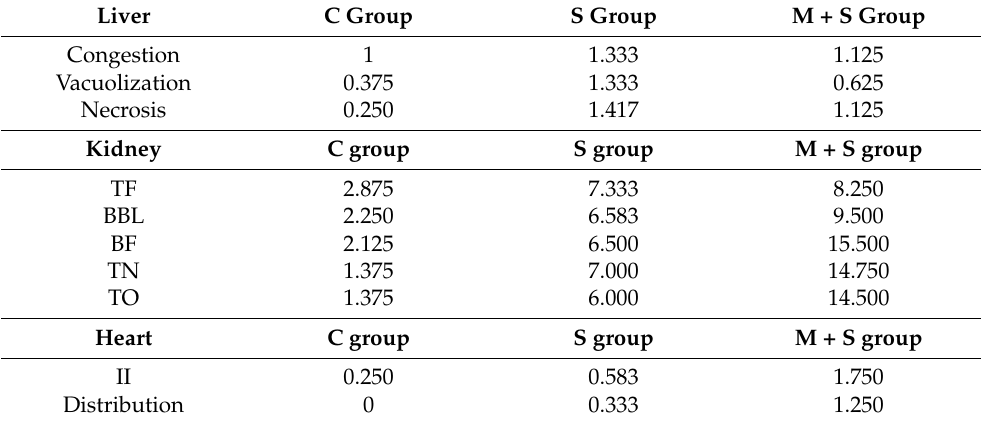
Table 2. Tissue histological scores in liver, kidney, and heart of rats of control (C), sepsis (S), and meldonium + sepsis (M + S) groups: Liver Suzuki histological score (0–4) based on the sinusoidal congestion, vacuolization of hepatocyte cytoplasm, and parenchymal necrosis (0—no changes, 1— minimal changes, 2—mild changes, 3—moderate changes, 4—severe changes); Renal histological score (0–4) based on the tubular epithelial cell flattening (TF), brush border loss (BBL), bleb formation (BF), tubular necrosis (TN), and tubular lumen obstruction (TO) (0—no changes, 1—minimal changes, 2—mild changes, 3—moderate changes, 4 or greater—severe changes); Heart histological score (Dallas criteria) based on the extent of inflammatory infiltration (II) (0—no changes, 1—mild changes, 2—moderate changes, 3—severe changes), and its distribution (1—focal, 2—confluent,